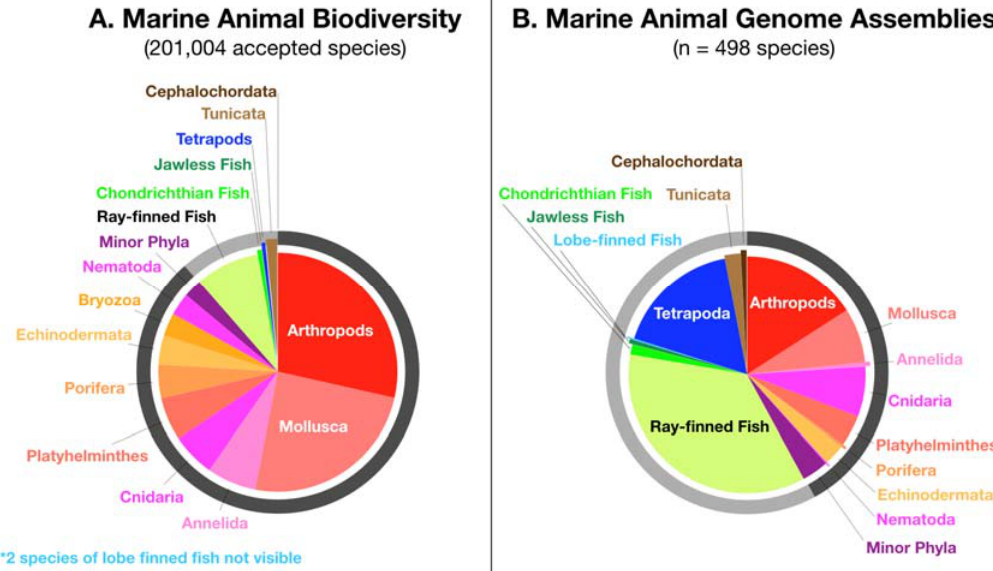
Figure 2. Comparing actual marine animal biodiversity to sequenced marine animal genomes. ( A ) Presents the proportionate taxonomic biodiversity of all accepted marine species [89]. ( B ) Presents the breakdown of marine animal genome assemblies deposited to the National Center for Biotechnology Information as of September 2019. Eleven of the phyla in ( A ) (including one major and ten minor) have yet had a single genome sequenced and assembled. These include Bryozoa, Sipuncula, Nematomorpha, Gnathostomulida, Gastrotricha, Entoprocta, Dicyemida, Cycliophora, Chaetognatha, Aschelminthes. Several of these missing phyla are entirely marine, meaning they are wholly unrepresented in genomics. Outer circles of ( A , B ) delineate nonchordate invertebrates (dark gray) from the phyla chordata (light gray), which has been further subdivided, revealing a gross over-representation of sequenced genomes for vertebrate classes compared to entire invertebrate phyla.